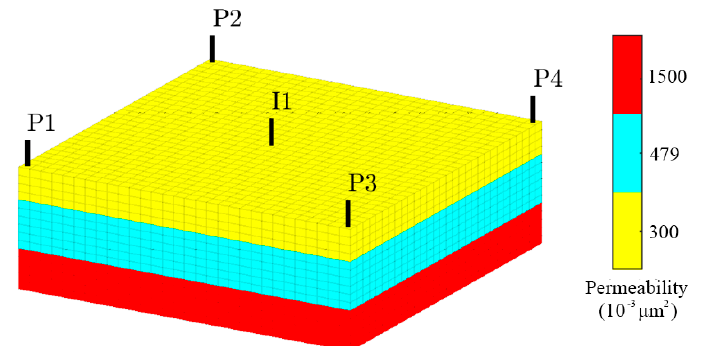
Figure 2. Permeability distribution of the positive − rhythm synthetic